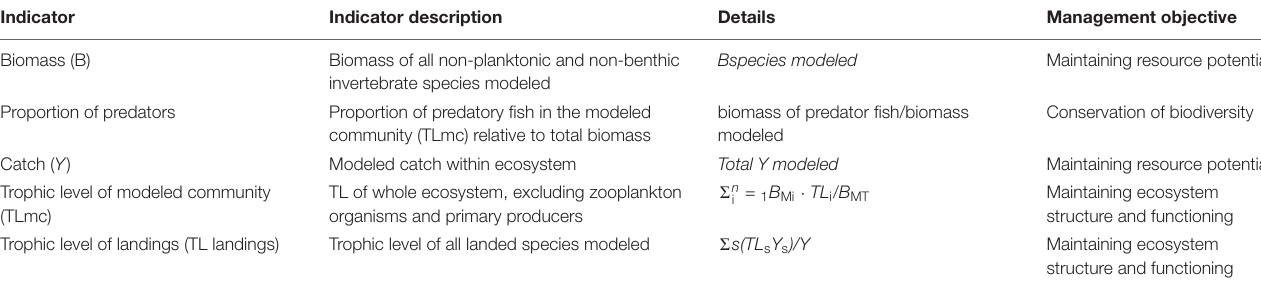
TABLE 3 | Description of indicators used in this study, alongside equations of how indicators were calculated.